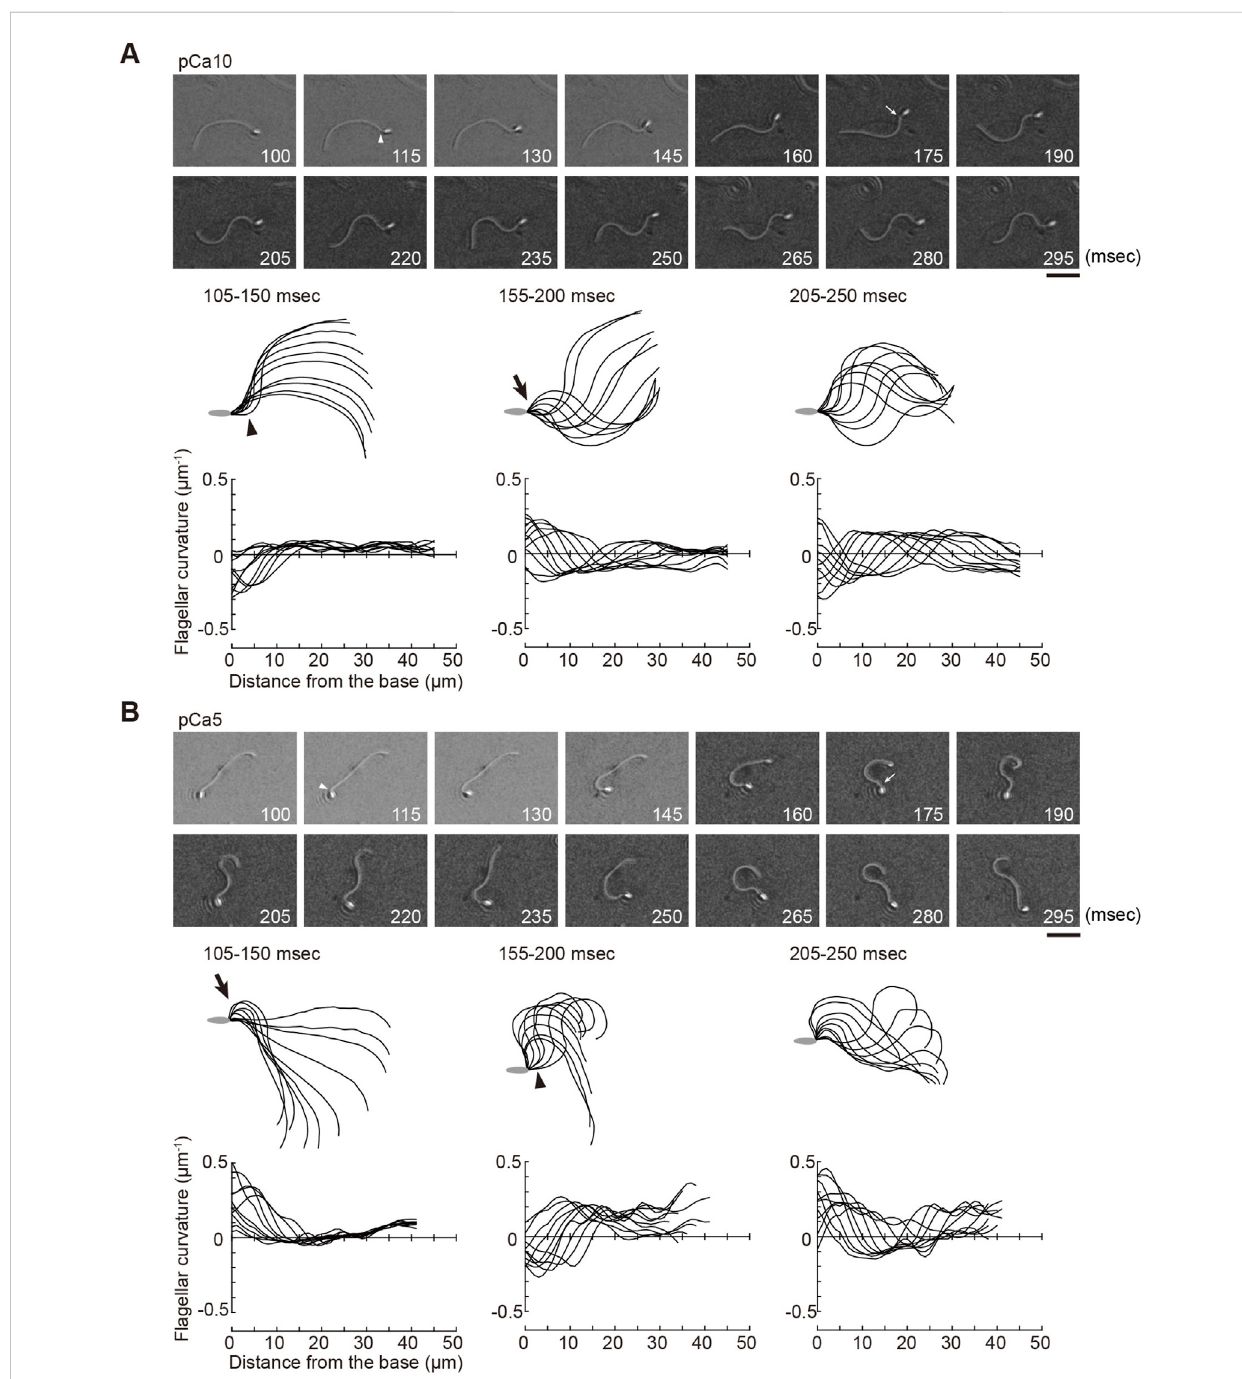
FIGURE 2 Generationofsymmetricandasymmetric fl agellarwaveformsin Ciona spermbyphotolyticreleaseofcagedATP.Spermcellsweredemembranated and incubated in thereactivation solution with caged ATP atlow (pCa10; (A) )orhigh (pCa5; (B) )Ca 2+ concentrations. Release ofATP was triggered byUV fl ash.Upperpanel:sequentialimagesofsperm fl agellarwaveformsat15 ms-intervalsfrom100 msaftertheUV fl ash.Arrowheadsandarrowsindicatethe initialbendandthesecondbend,respectively.Scalebar,20 μ m.Middlepanel:overwrittenimagesofdemembranatedspermat5 msintervalsduring the periods of time (105 – 250 ms) after release of ATP. Arrow heads and arrows indicate the initial bend and the second bend, respectively. Lower panel: changes of fl agellar curvature occurring 105 – 250 ms after the UV fl ash are plotted against the distance from the base of fl agellum. Ten waveforms produced at 50 ms are overwritten. Symmetric and asymmetric waveforms were generated in low calcium concentrations (pCa10, (A) ) and high calcium concentrations (pCa10, (B) ), respectively. One typical sperm example from the all experiments at least three times with three different specimens was